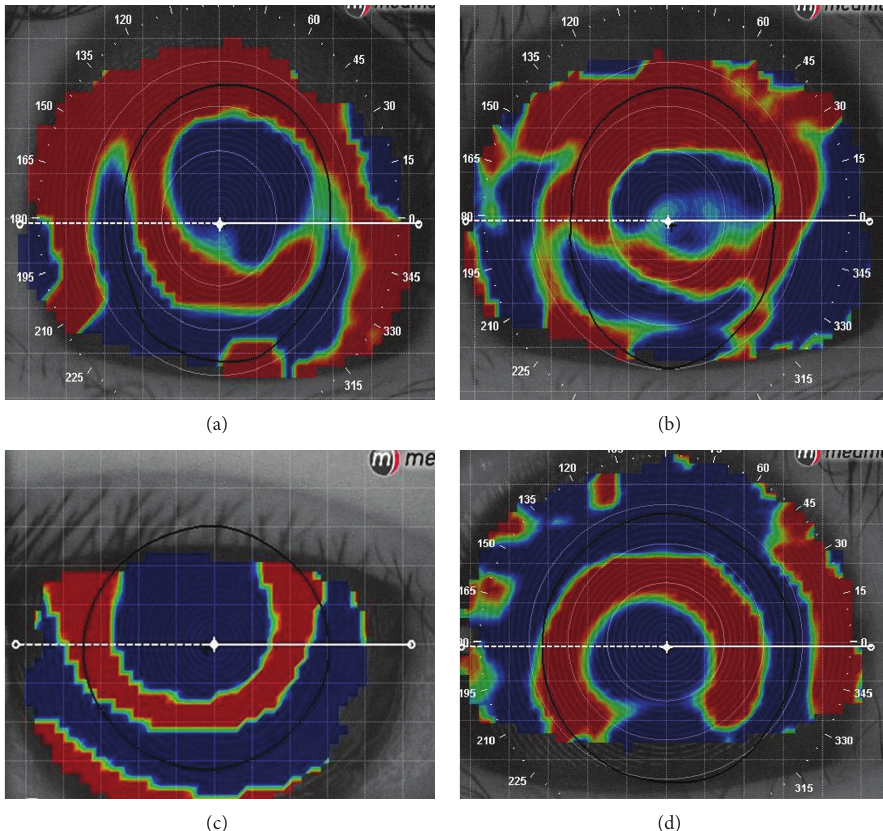
Figure 4: Image of an incomplete “inversion arc.” (a) The incomplete acquisition of image data made the boundary of the “inversion arc” discontinuous. (b) Although the boundary of the “inversion arc” was discontinuous, induced by incomplete acquisition of image data, inner boundary was continuous, so the complete treatment zone could be drawn. (c) The boundary of the “inversion arc” was discontinuous, induced by incomplete acquisition of image data. (d) The boundary of the “inversion arc” was discontinuous, induced by